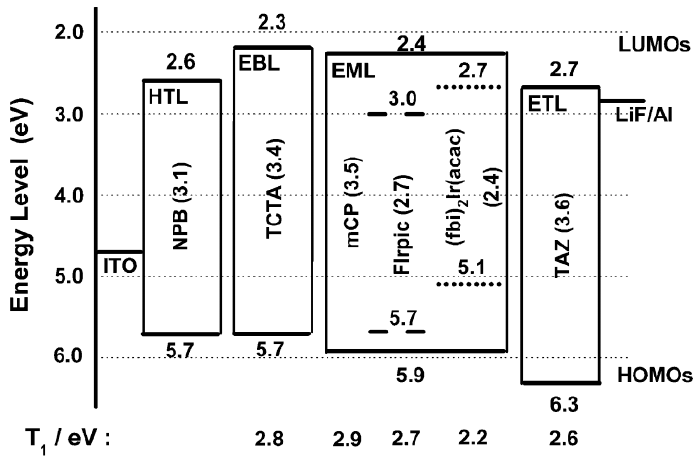
Figure 7. Structure of the WOLED and the proposed energy level. TAZ is 3-(4-biphenyl)-4-phenyl-5- (4-tert-butylphenyl)-1,2,4-triazole, which was employed as the ETL. Reproduced from Reference [125].